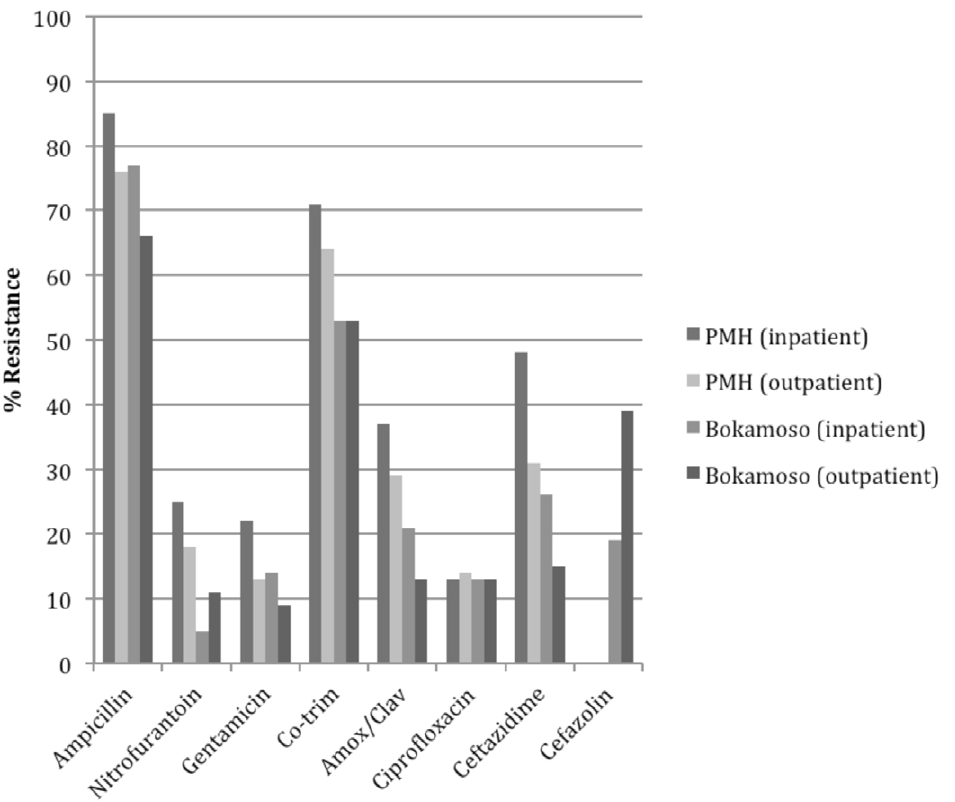
Figure 1. Antimicrobial resistance patterns of all UTI pathogens. * *Less than 15 samples analyzed for these antimicrobials as noted: PMH- Outpatients (ciprofloxacin, ceftazidime).